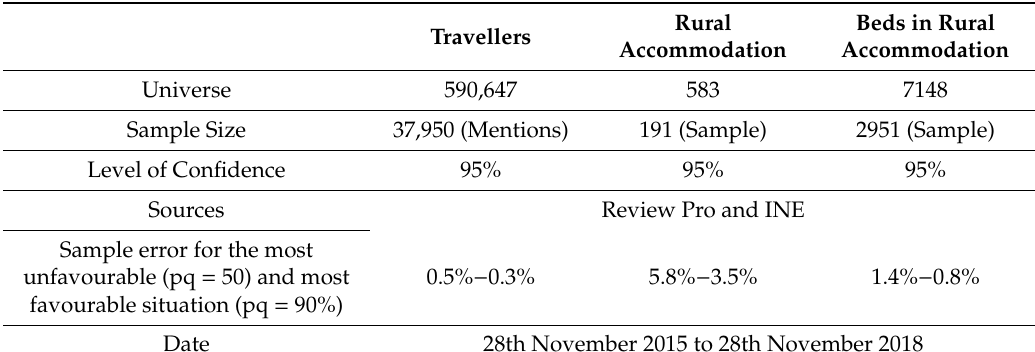
Table 2. Data sheet of the